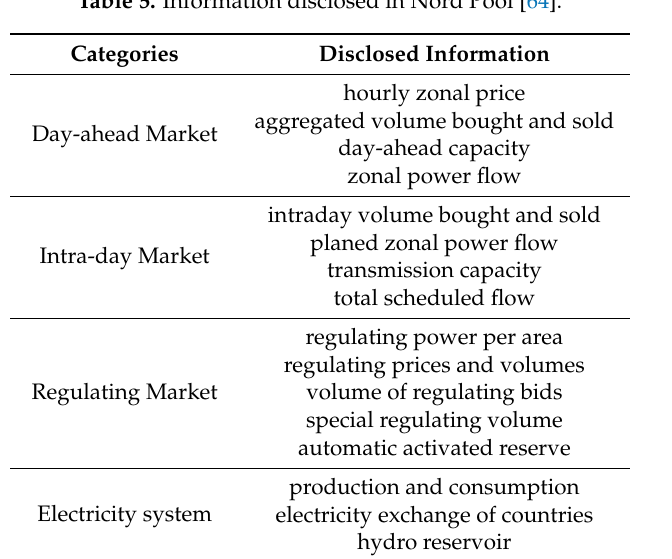
Table 5. Information disclosed in Nord Pool